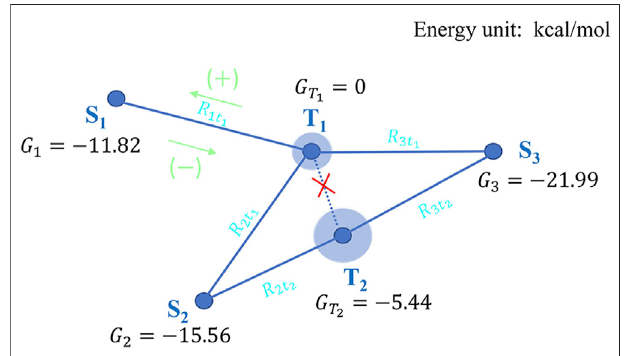
FIGURE 7 | The representation of the PD-L1 multiple-states system according to GITR